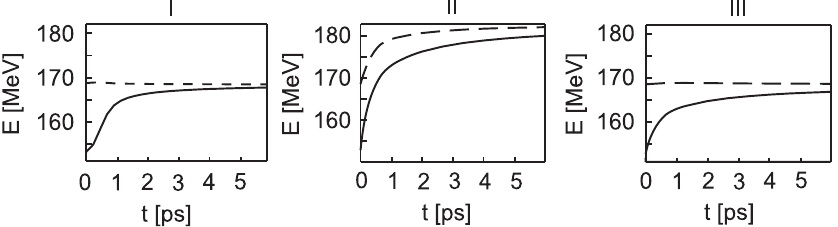
FIG. 4. The solid line shows the kinetic energy. The dashed line shows the total energy which is the sum of kinetic energy and field energy using Eq. (1). The calculations correspond to Fig. 3.